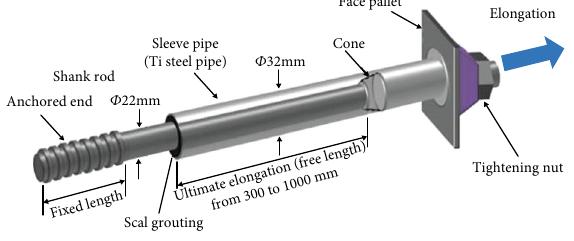
Figure 11: Structure diagram of CRLD cable.